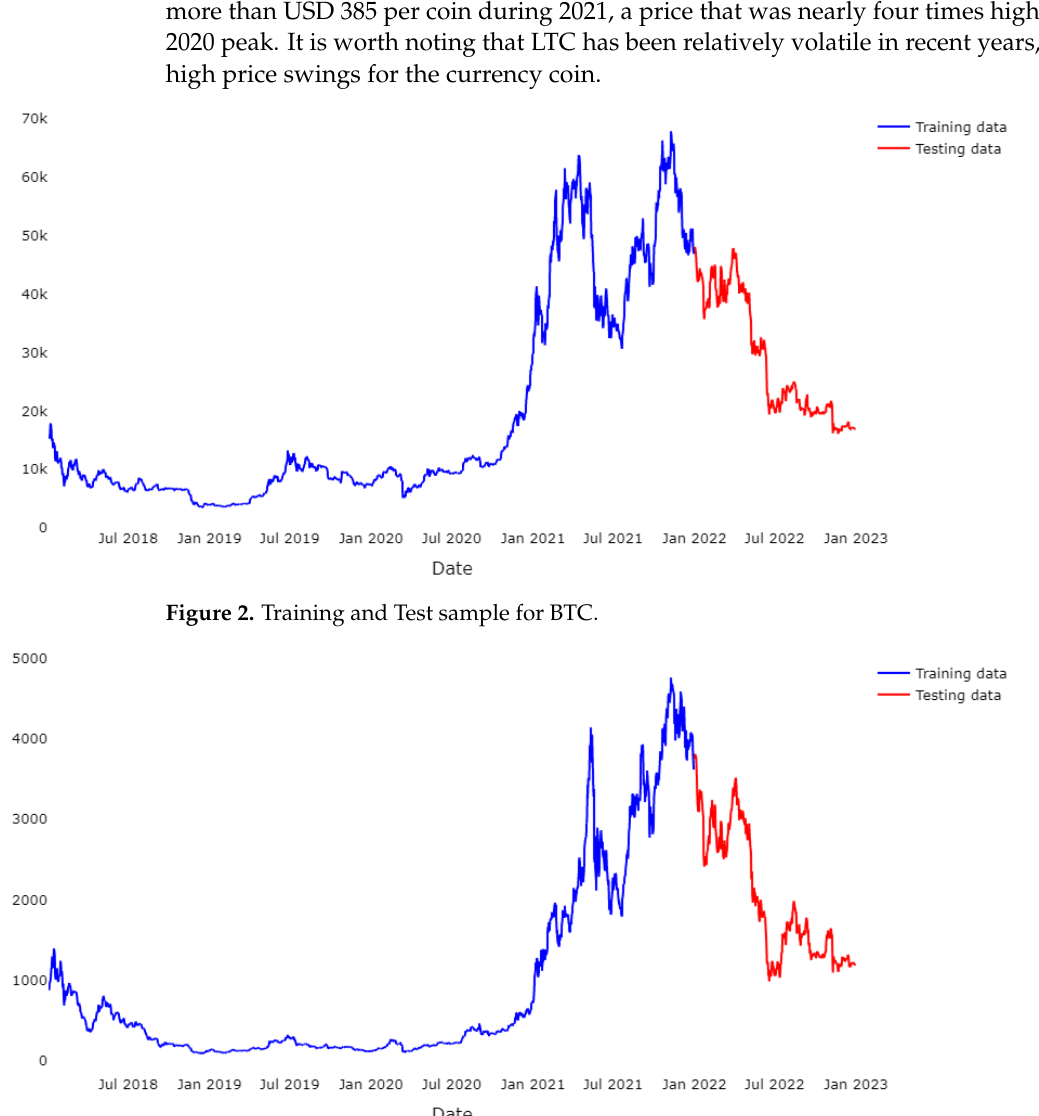
Figure 3. Training and Test sample for